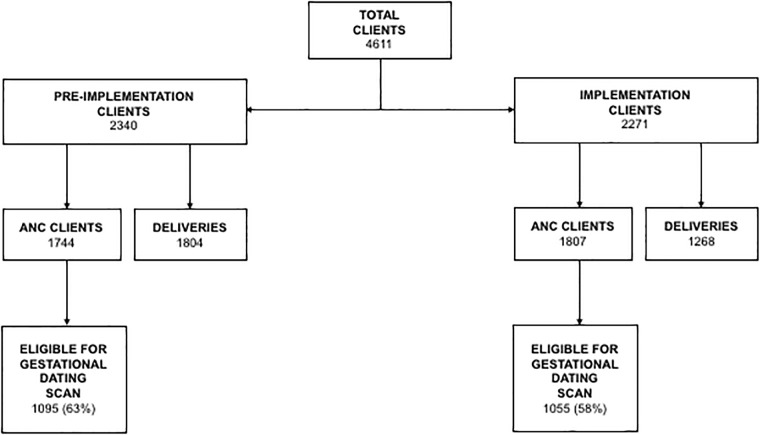
Client flowchart.